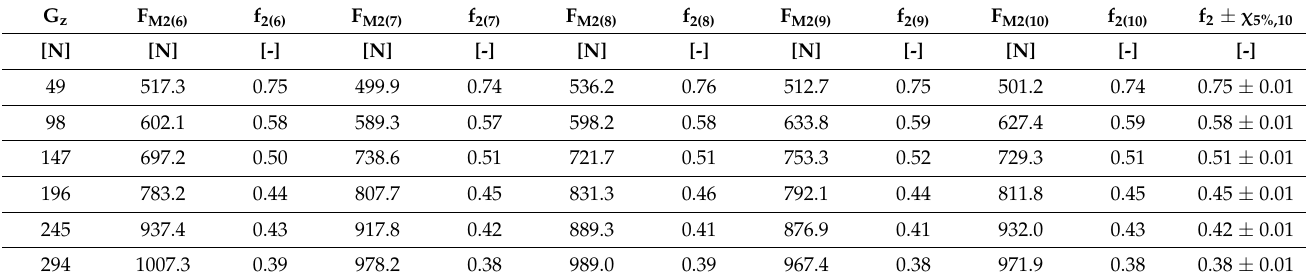
Table 5. Tensile force F M2(i) [N] , ϕ6 mm rope, semi-circular groove, contaminated with oil.